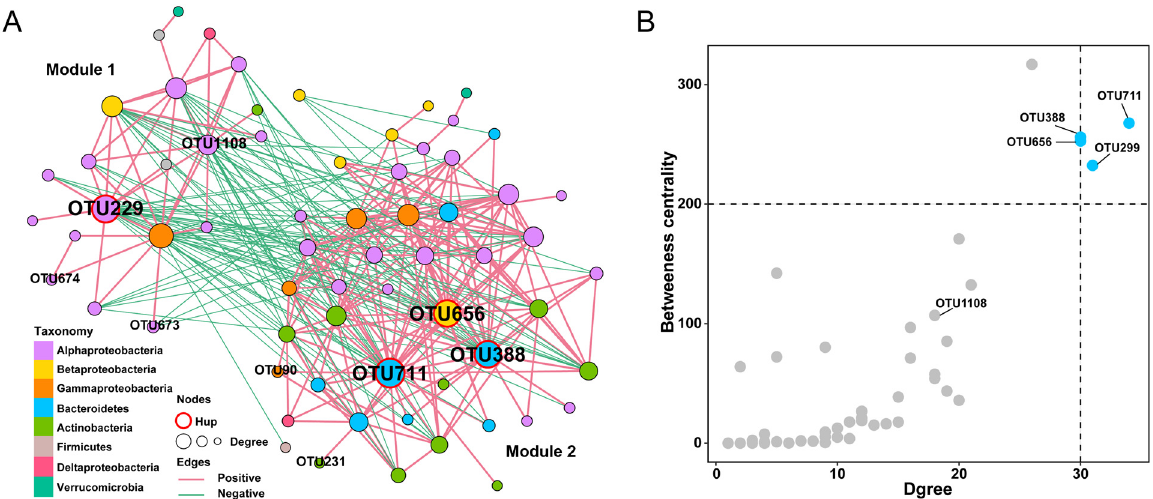
Figure 6. Microbial network of B. napus rhizosphere microbiota. ( A ) Co-occurrence network of B. napus is based on 79 samples of B. napus including synthetic lines. Each node corresponds to an OTU, and edges between nodes correspond to positive (pink) or negative (green) correlations inferred from OTU abundance profiles using the SparCC method (pseudo p < 0.01, correlation values < − 0.7 or > 0.7). OTUs belonging to different microbial phyla have different colors. Proteobacteria is shown at the class level. The node size reflects their degree in the B. napus rhizosphere. ( B ) Hub OTUs of B. napus. The dotted line indicates the threshold of hub OTUs.